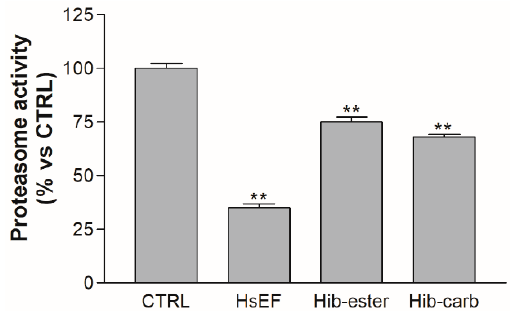
Figure 7. Proteasome activity of RPMI 8226 cells. The graph represents proteasome activity of RPMI 8226 cells, not treated (CTRL) or treated with HsEF 3 mg/mL, Hib-ester 450 µ g/mL and Hib-carbaldehyde 200 µ g/mL for 24 h. Data are represented as the mean percentage ± SD, compared to CTRL, arbitrarily set to 100%. (** p < 0.01 vs. CTRL).